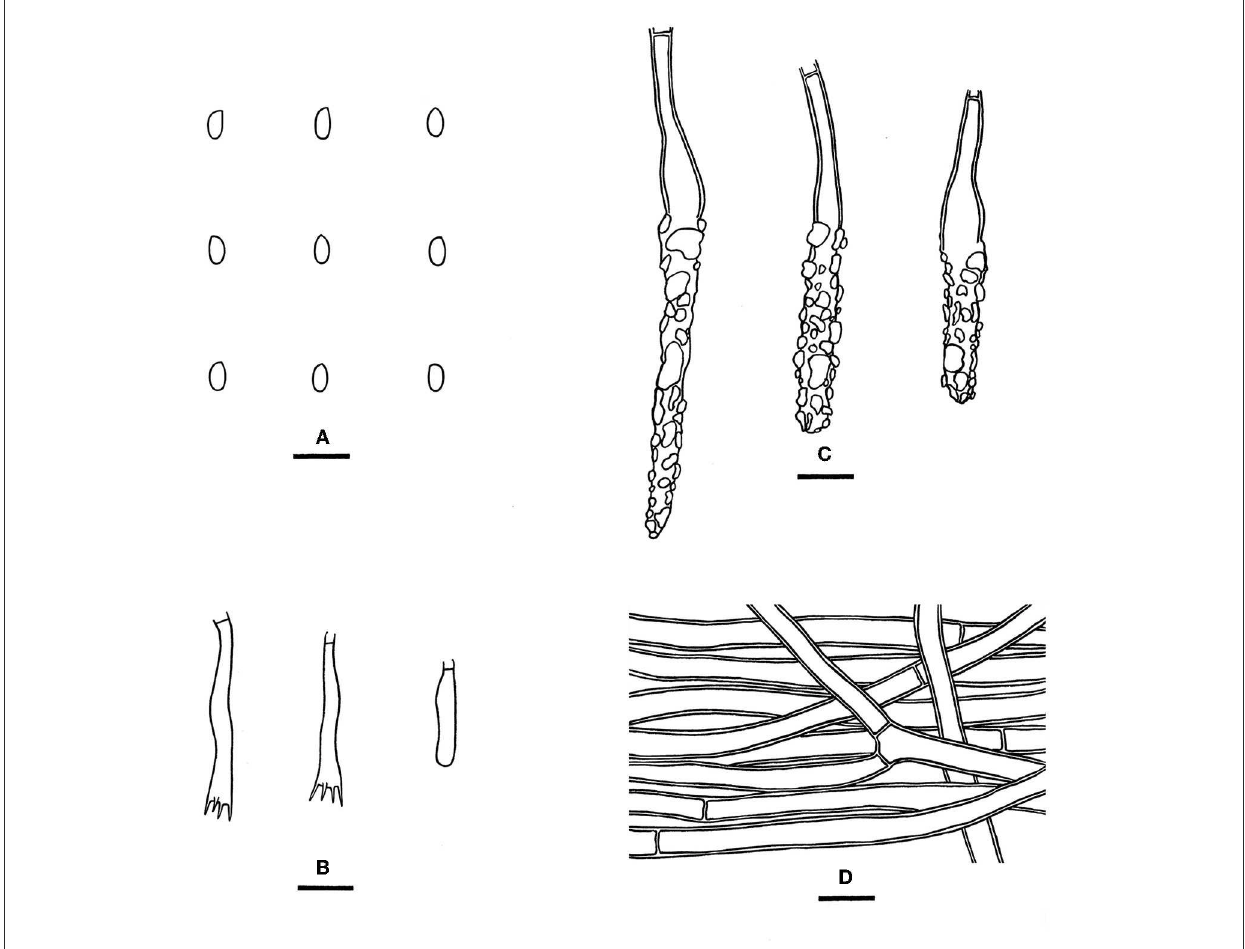
FIGURE10 Rhizochaete subradicata [from the holotype He 3213; scale bars: (A–D) = 10 µ m]. (A) Basidiospores; (B) Basidia and a basidiole; (C) Lamprocystidia; (D) Hyphae from